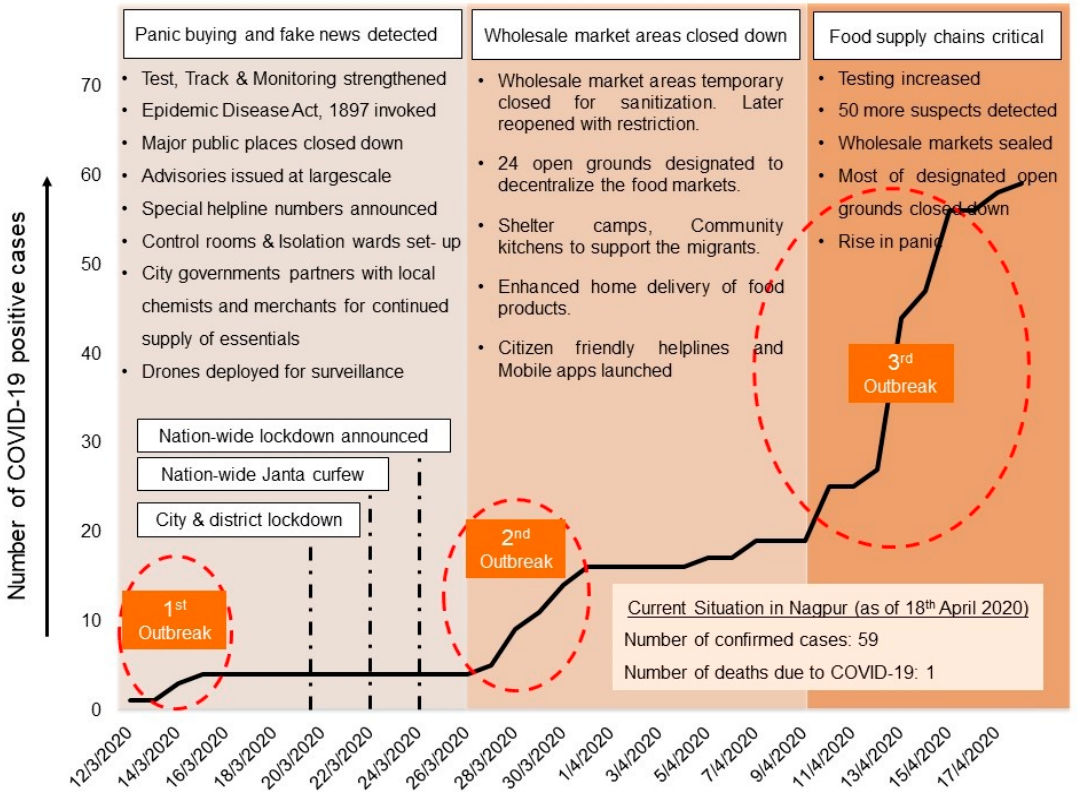
Figure 2. Timeline of COVID-19 outbreak in Nagpur, its chronological implications and Government response measures (prepared by the authors in reference to the COVID-19 Monitoring Dashboard maintained by Public Health Department, Government of Maharashtra [31]).